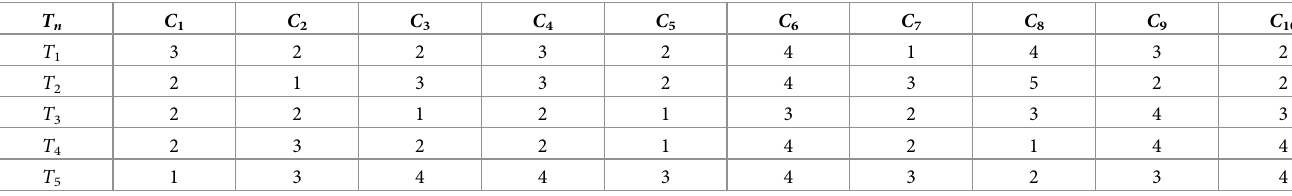
Table 9. The demander’s expectation of the urgency of the material